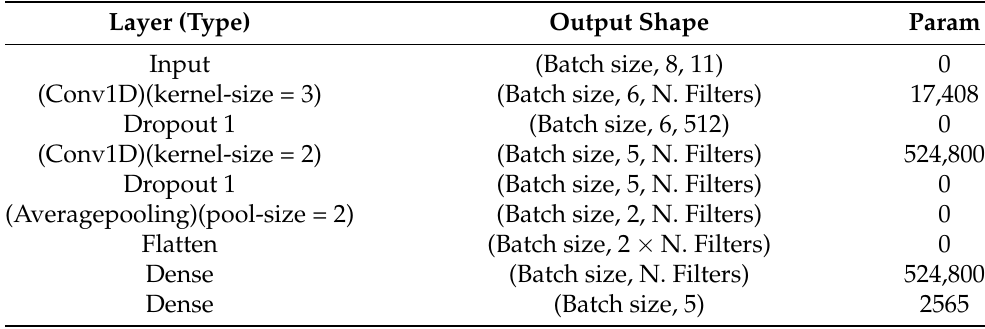
Table 10. CNN architecture used to compare to the LSTM model.